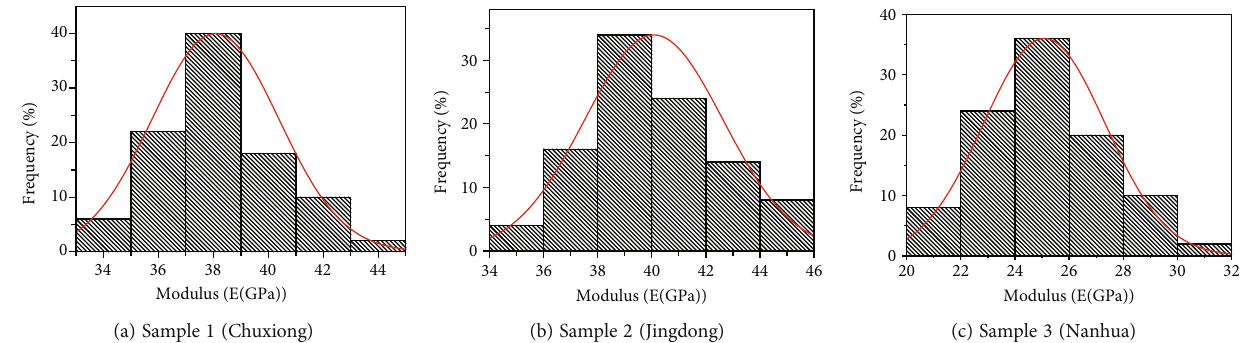
Figure 13: Normal distribution diagrams of elastic modulus of Yunnan red-bed mudstone in three regions.